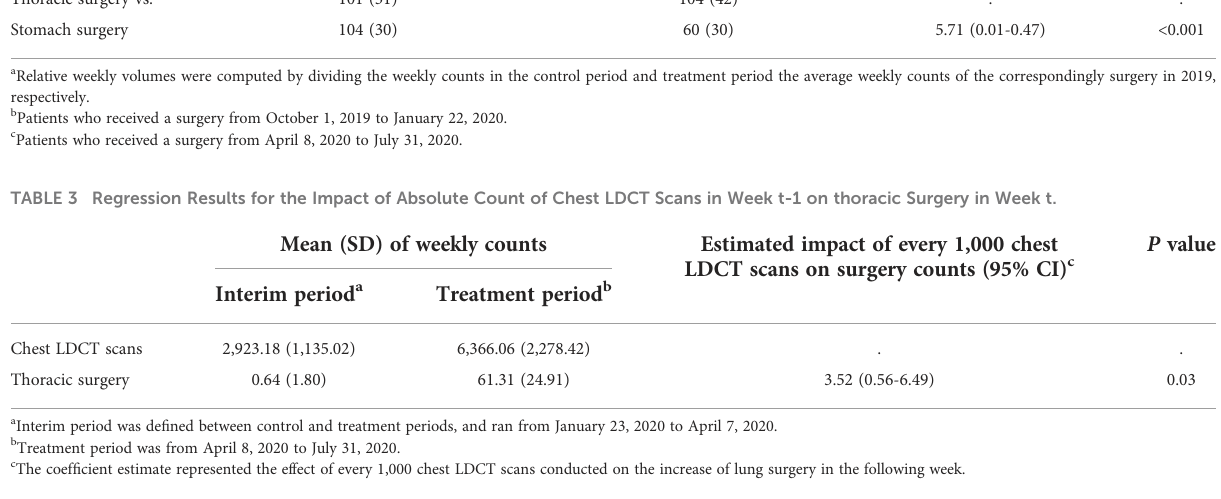
Thoracic surgery vs.